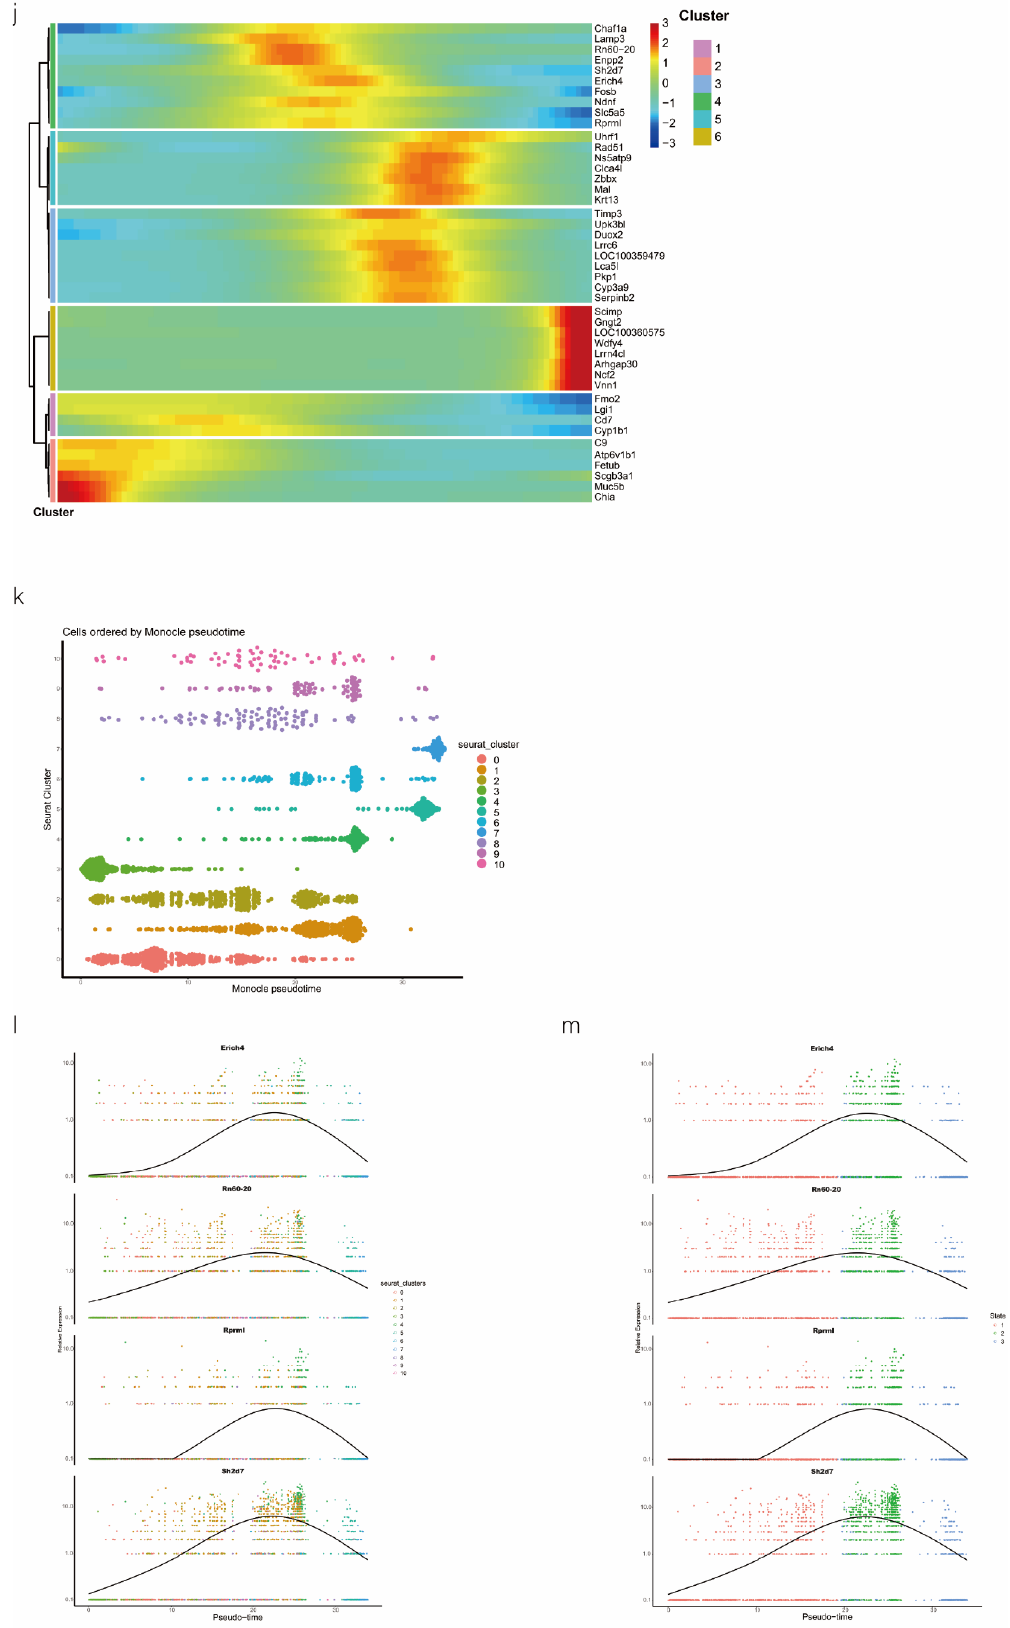
Figure 1. scRNA-seq of alveolar lavage cells isolated from rats in the normal control (NC) and phosgene-induced CALI model (Gas) groups. Sprague–Dawley rats were treated with phosgene